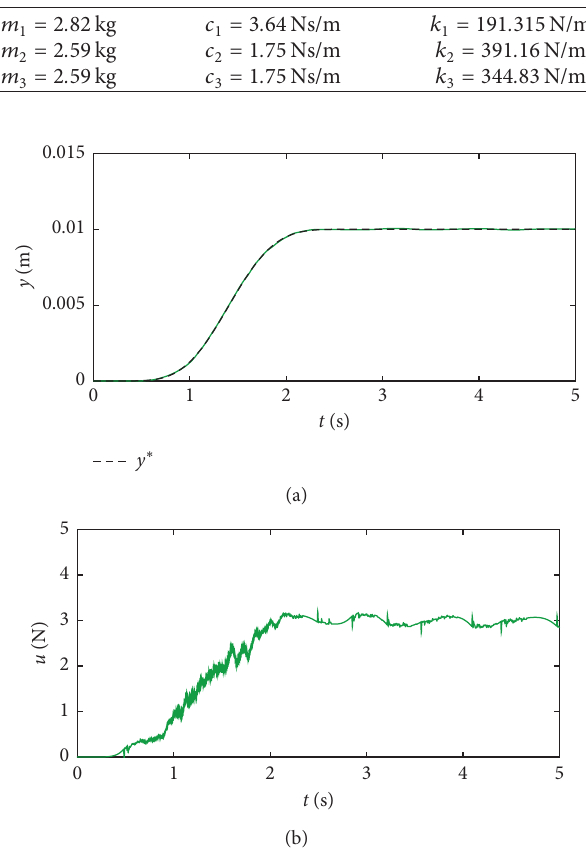
Figure 2: Experimental results for trajectory tracking planned for the controlled mass.